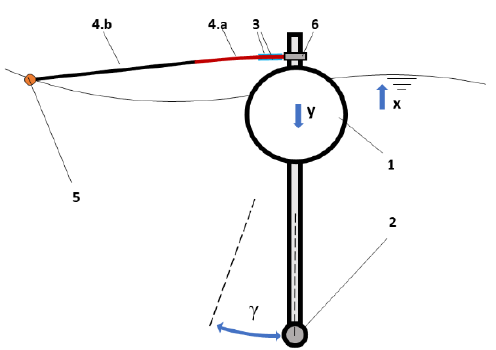
Figure 2. Scheme of the energy conversion apparatus for the Lab on sea unit: 1. spar buoy; 2. ballast; 3. piezoelectric patch transducers (PPTs); 4. band (a) deformable part, (b) rigid part; 5. external float; and, 6. rod grip. The vertical direction of the wave motion is indicated with x , while y is the vertical displacement of the spay buoy and γ is its angular oscillation.